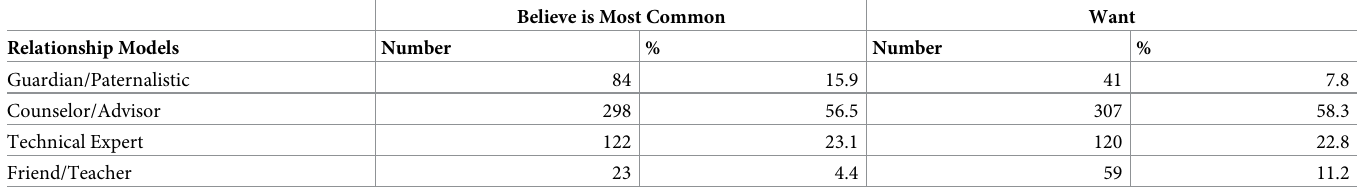
Table 4. Number and percent of respondents indicating how common they think each type of patient-provider relationship is, and which model they want. Believe is Most